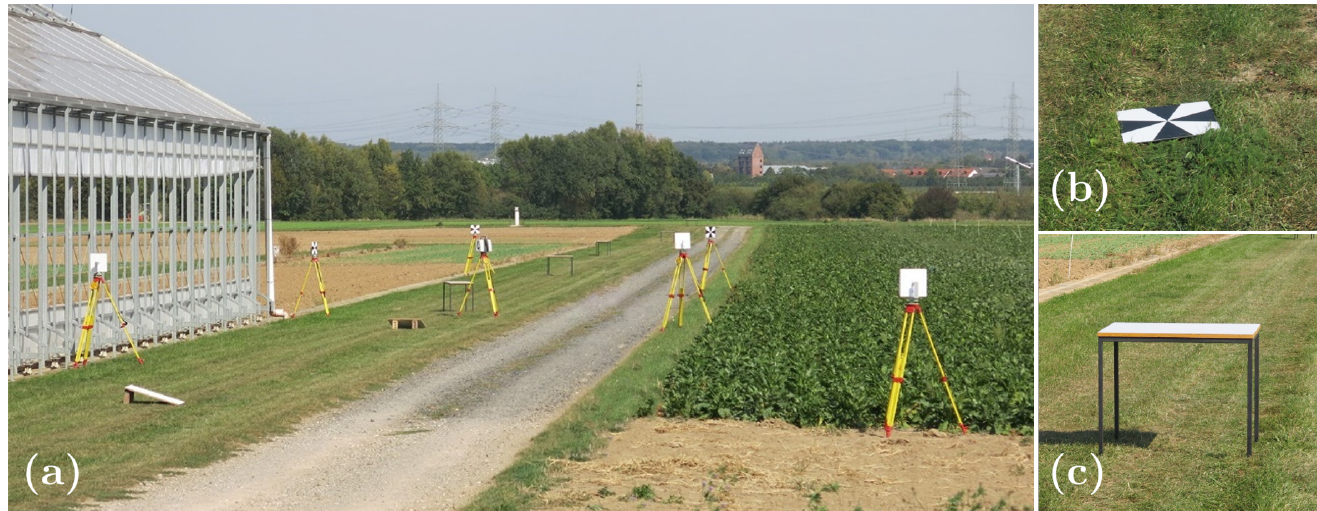
Figure 4. Study area for the analysis of single strip measurement with TLS measurement for the reference point